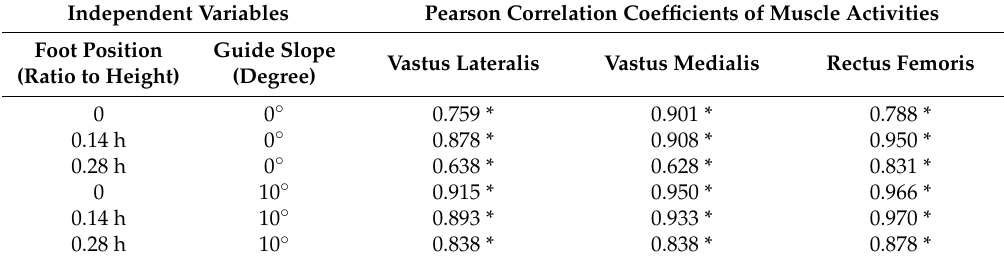
Table 3. Pearson correlation coefficients of measured and simulated muscle activities of right leg (*: p < 0.001).